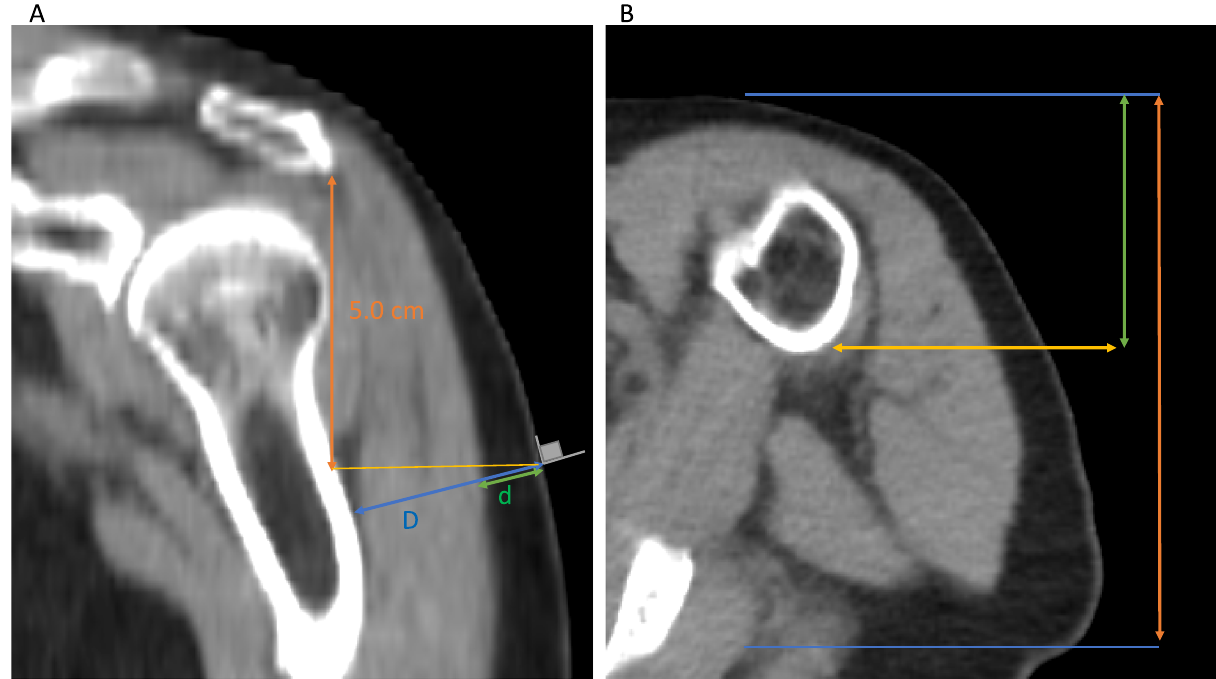
Figure 1. ( A ) Coronal CT image of a 77-year-old man with history of head and neck squamous cell carcinoma, weight of 74 kg, height of 1.70 m, demonstrating the deltoid subcutaneous fat pad (DSFP) measurement technique. Orange arrow identifies the region exactly 5.0 cm inferior to the acromion. Yellow line is perpendicular to the orange line and identifies the estimated injection site. 90° angle at the estimated injection site in gray was used to identify the trajectory of the needle. Green arrow identifies the distance from the skin surface to the deltoid muscle measured perpendicular to the skin in the coronal plane (note arrow is jittered to show blue arrow along the same path) (DSFP = d = 11.2 mm). Blue arrow identifies the distance from the skin surface to the humerus measured perpendicular to the skin in the coronal plane (D = 40.3 mm). ( B ) Axial CT image of the same man demonstrating identification of the correct coronal plane to measure the DSFP. Blue lines identify the anterior and posterior borders of the shoulder 5.0 cm inferior to the acromion. The orange arrow measures the distance between the anterior and posterior borders of the shoulder. The green arrow measures the half-way distance between the anterior and posterior borders of the shoulder. The yellow arrow was used to identify the coronal plane to take measurements of the deltoid subcutaneous fat